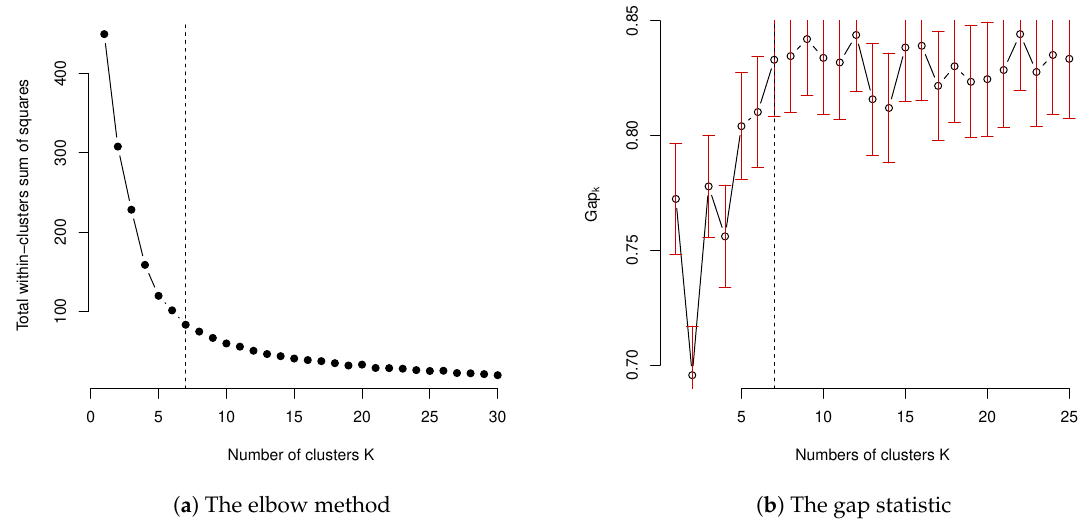
Figure 4. The selection of the number of clusters based on both the elbow method and the gap statistics. The vertical dotted line is at K =